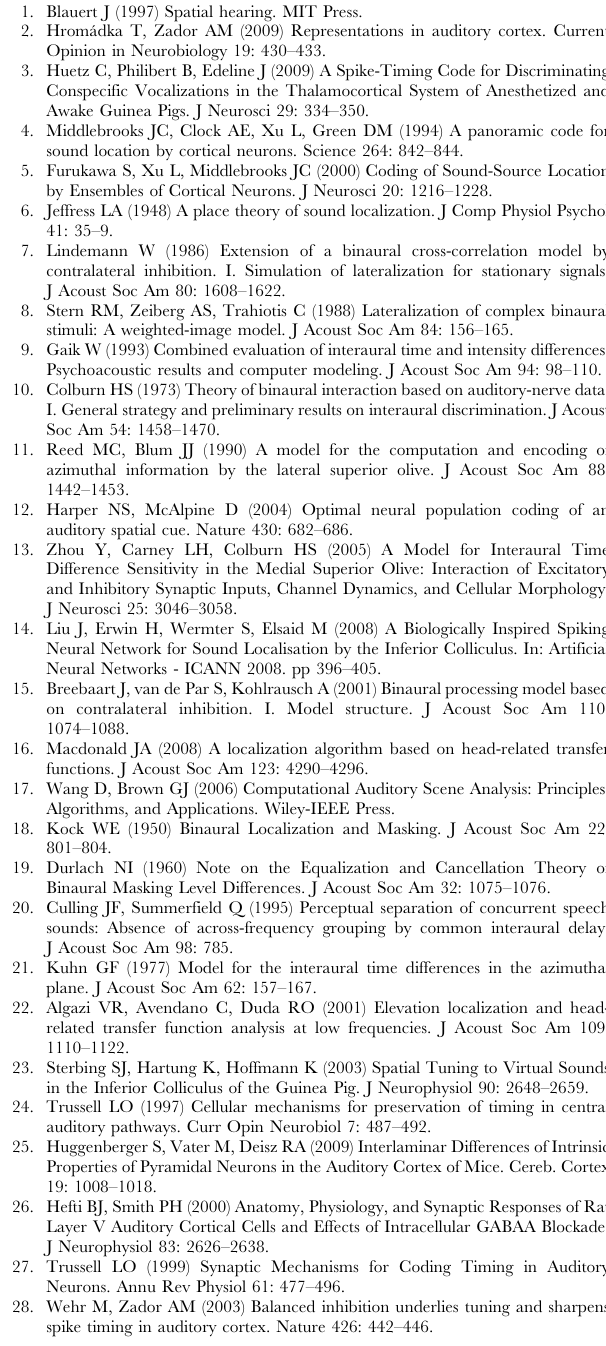
(2f) and 1/(2f) with the same phases. Colors and lines follow the same conventions as in Figure 6. (A) Error in azimuth. (B) Error in elevation. (C) Categorization performance (as in Figure